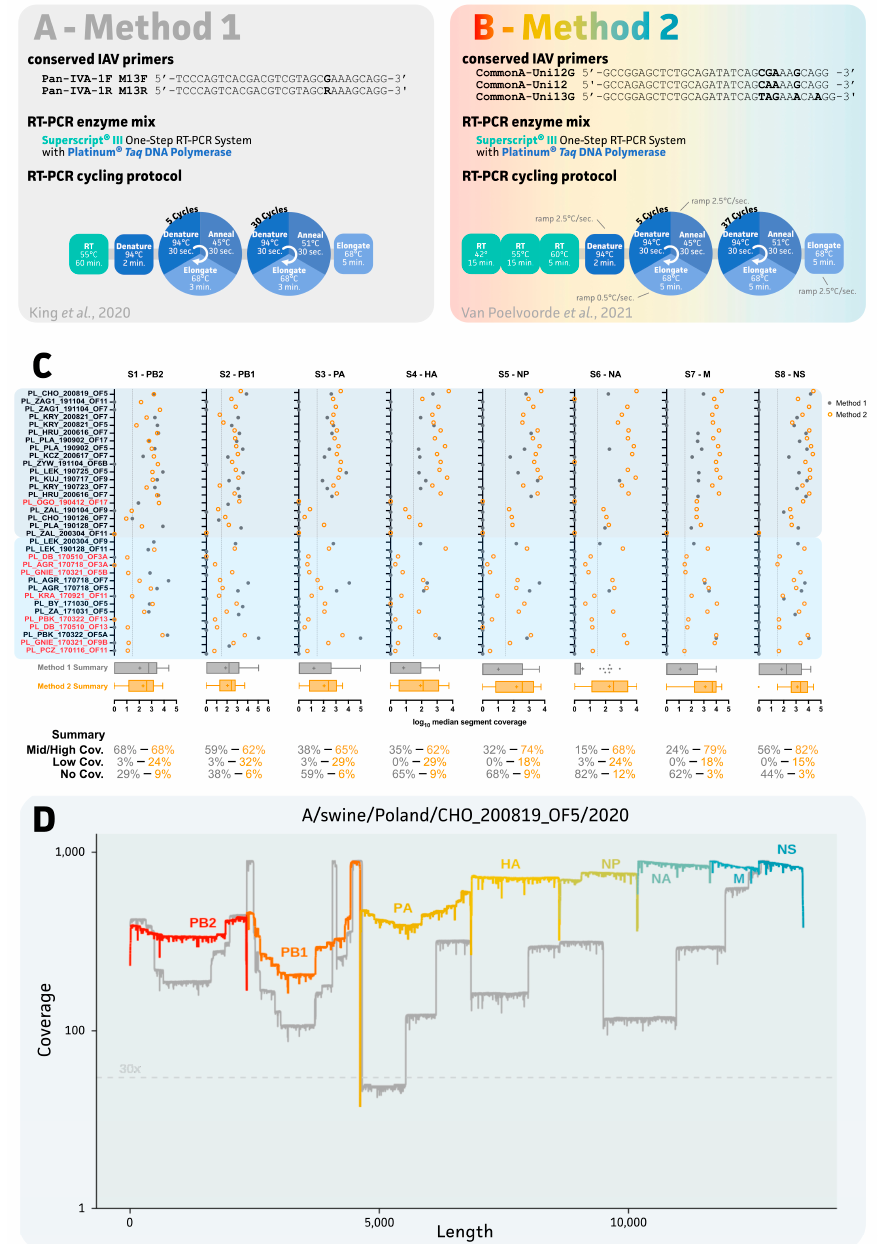
Figure 2. Comparative overview of sequencing procedures and swIAV segment coverage for two se- quencing protocols. ( A , B ) Schematic representation of two sequencing protocols that were compared in this study. ( C ) Impact on median segment coverage for each sample as represented by solid grey circles and open orange circles for method 1 and method 2, respectively. Sample names were colored according to RT-qPCR detection, where red indicates invalid (Cq > 31) samples for sequencing. For sample A/swine/Poland/LEK_200304_OF9/2020, no sequencing data were available for method 2. Box-and-whisker representation (Tukey) shows overall division and mean (+) of each method. ( D ) Example of coverage plot of concatenated swIAV segments (S1 up to S8) for a selected sample (A/swine/Poland/CHO_200819_OF5/2020), which was collected in 2020 and immediately stored at − 80 ◦ C. Grey and colored coverage plots represent segment-specific coverages for sequencing method 1 and 2, respectively. Note, sequencing coverage is represented on a logarithmic (log 10 ) scale on the both x- and y-axis. A dotted line was drawn to indicate the minimal required 30 × sequencing